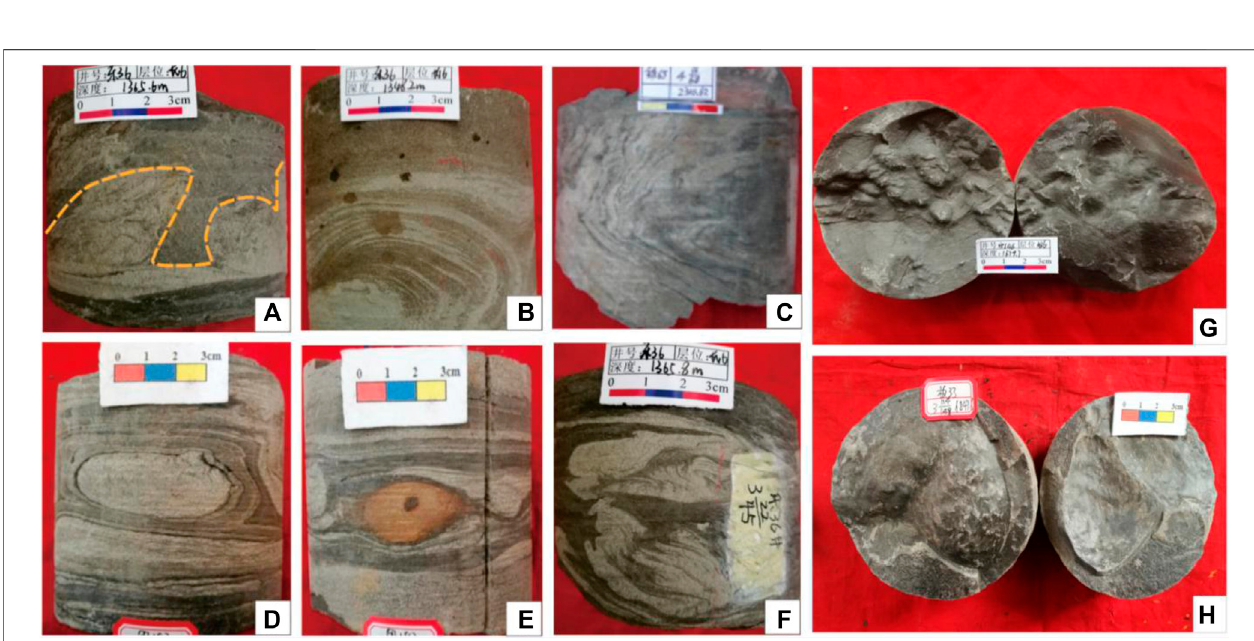
Frontiers in Earth Science |